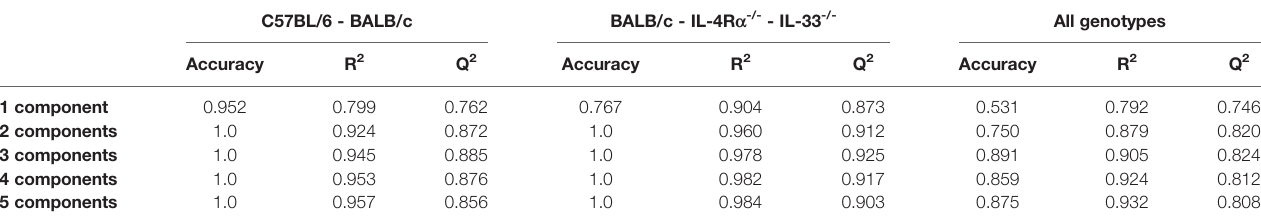
TABLE 1 | Accuracy of discriminant models in predicting cytokine, chemokine, and growth factor (CCG) pro fi les across mouse genotypes.